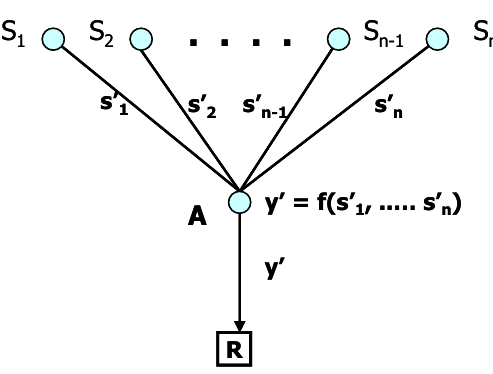
Figure 8. Data aggregation in